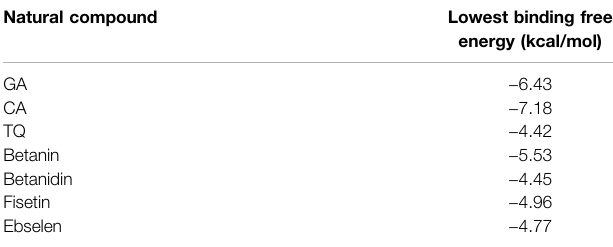
TABLE 1 | Molecular docking analysis results of natural compounds against SENP2 protein. Natural compound Lowest binding free